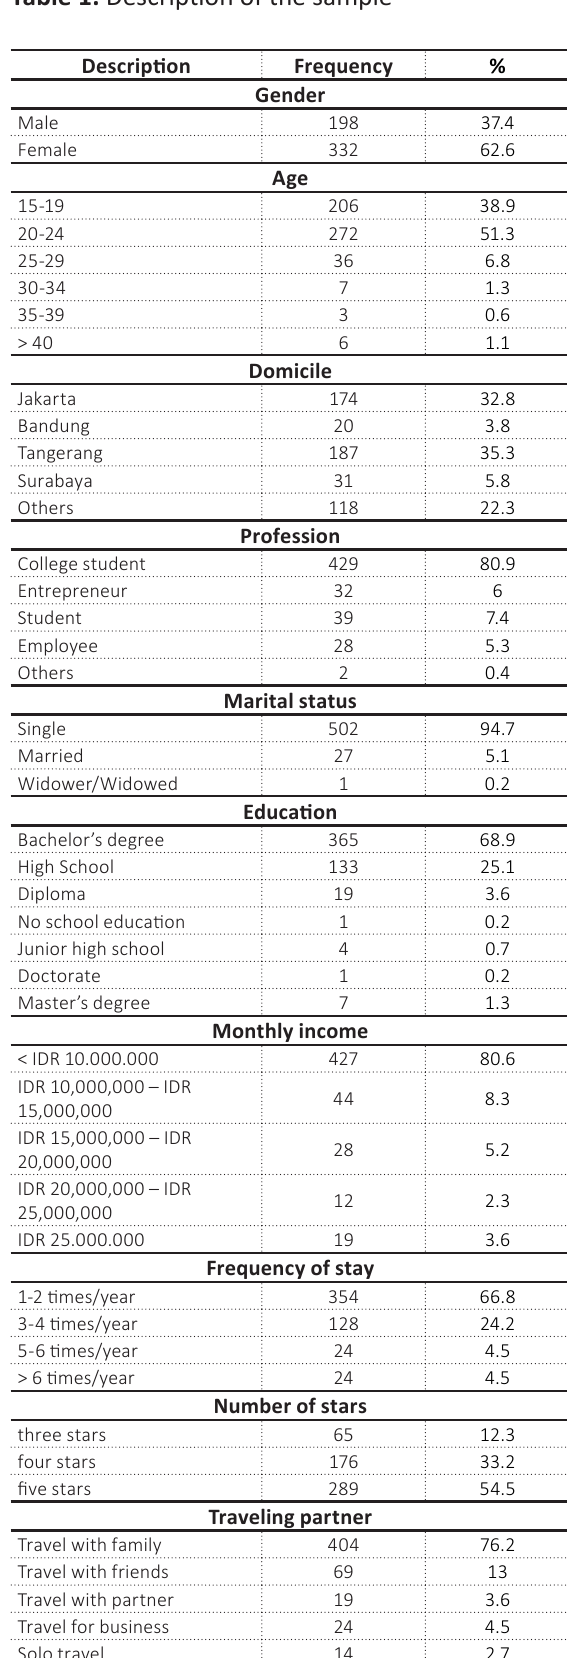
Table 1. Description of the